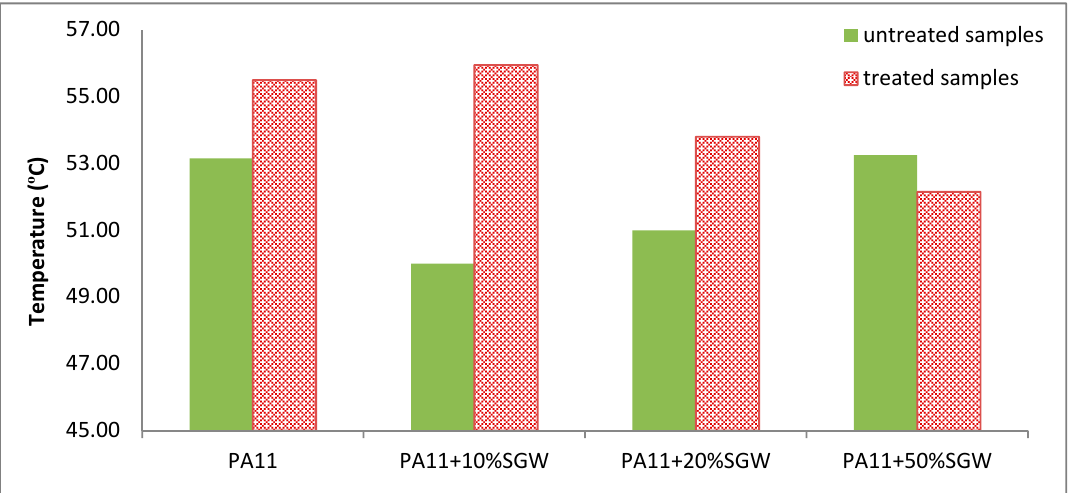
Figure 9. T g measured values for treated and untreated samples.